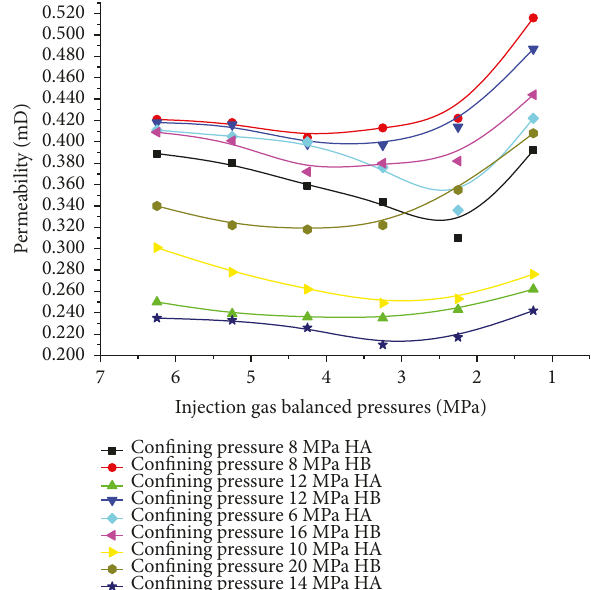
Figure 4: Permeability variation of the HA and HB coal specimens under di ff erent con fi ning and injection